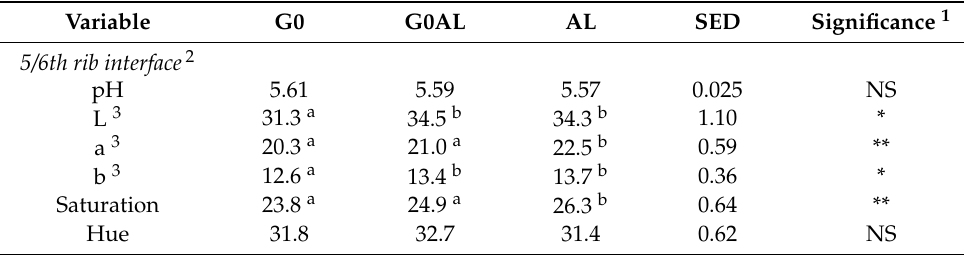
Table 2. pH and colour 1 of the longissimus muscle 2 of suckler bulls slaughtered after: 199 days at pasture (G0); 98 days at pasture followed by 101 days indoors and offered concentrates (G0AL); and 199 days indoors and offered concentrates